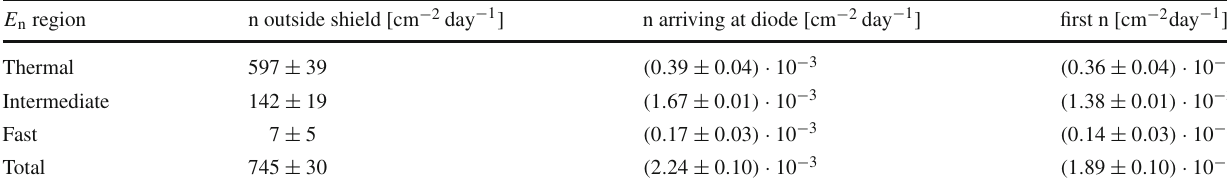
the reactor. The measured neutron spectrum inside A408 has been used as input for the simulation. The definition of the E n regions is identical to Table 6